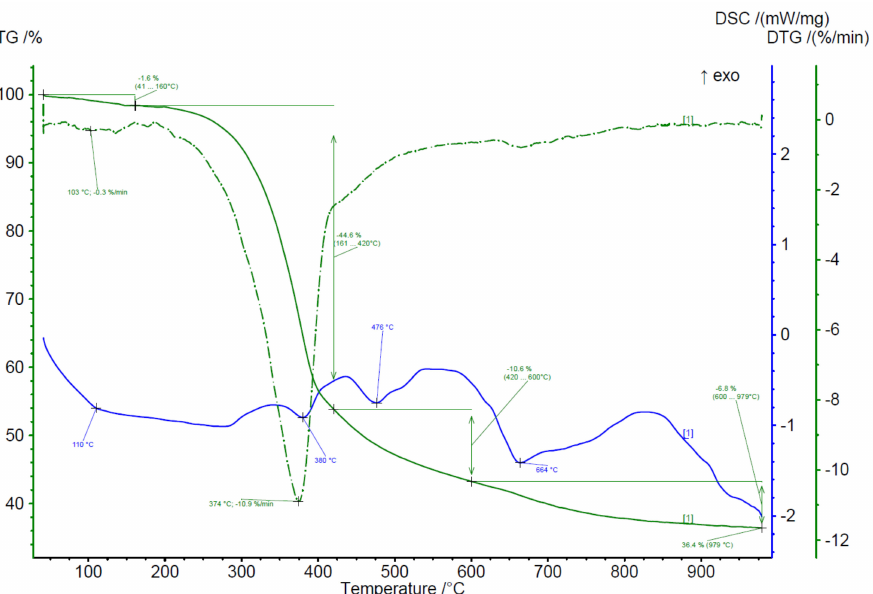
Figure 7. Results of simultaneous thermal analysis in the air atmosphere on the example of BWW with an 82-year storage